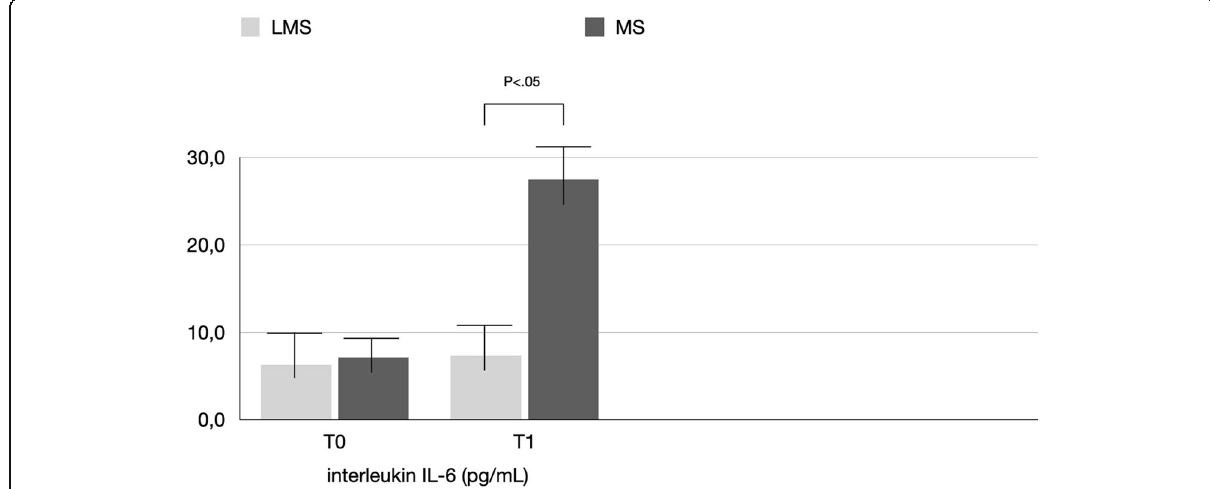
Fig. 6 Comparison of the level of interleukin IL-6 (pg/mL) detected in the LMS and MS groups